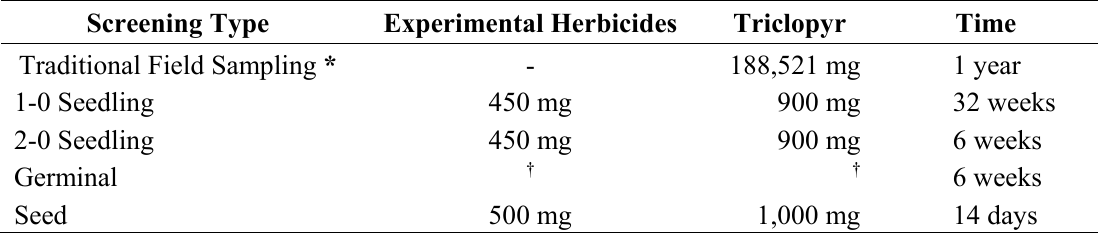
Table 8. Resources required for rapid screening: amount of herbicide acid equivalent used (mg) and time (from herbicide application to end of